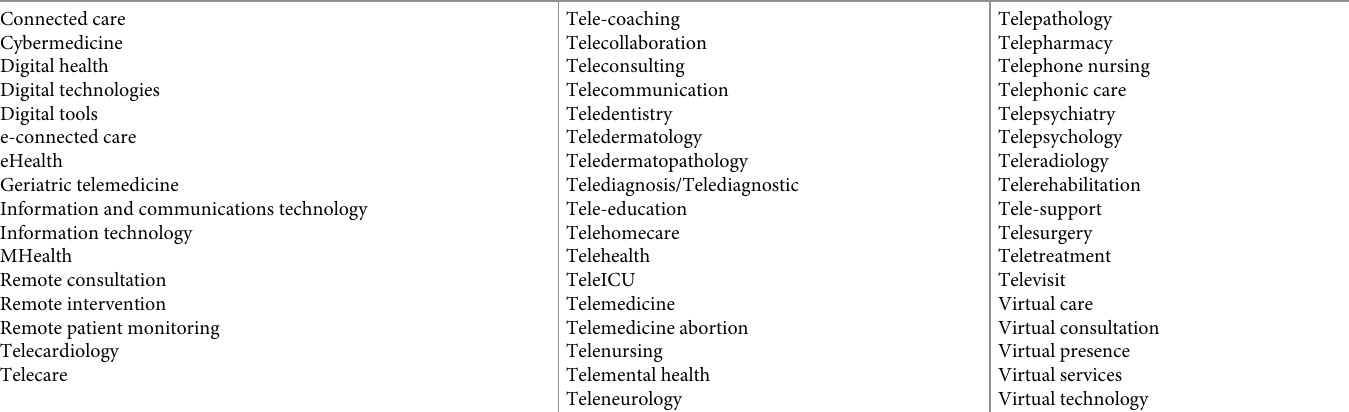
Table 1. Examples of terms used in the academic literature to describe practice encounters not involving in-person